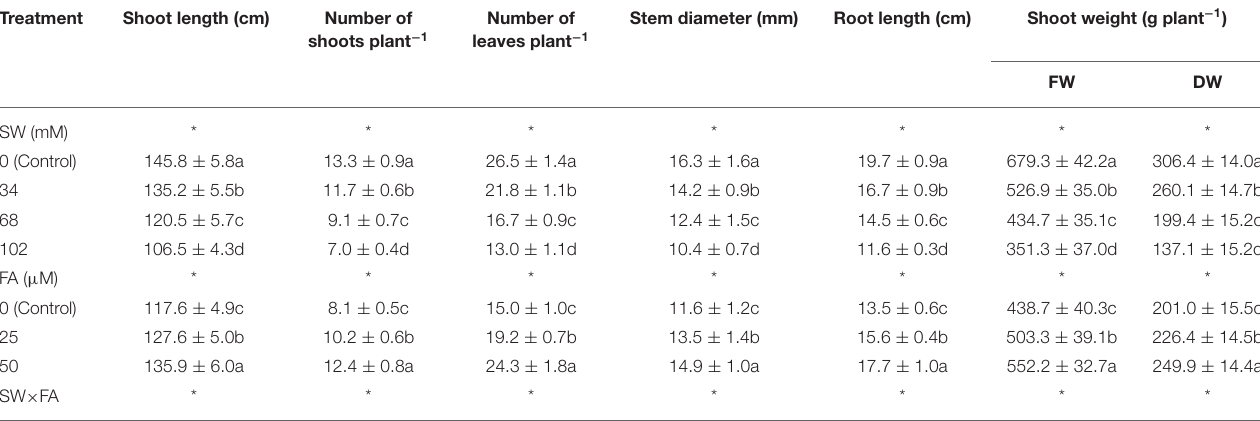
TABLE 1 | The effect of SW irrigation and FA spraying on growth characteristics of Plectranthus amboinicus plants grown under greenhouse conditions. Treatment Shoot length